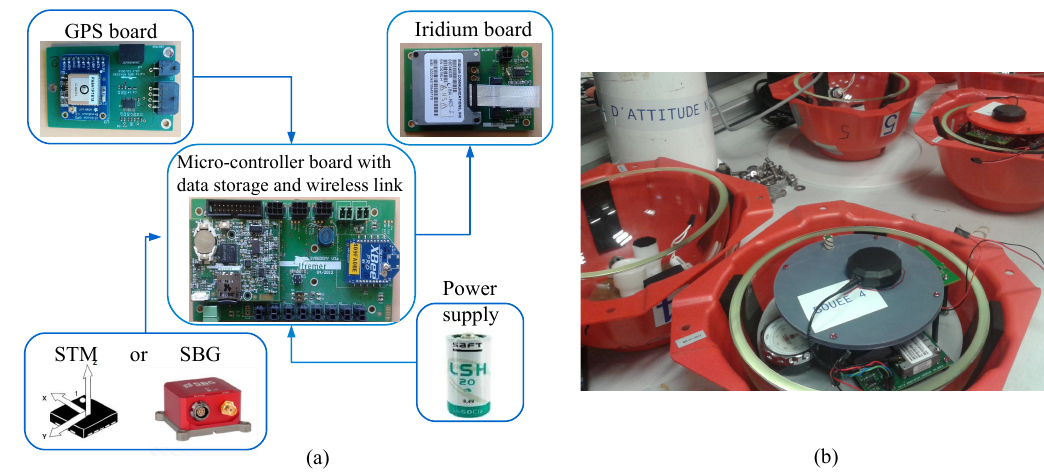
Figure 1. Surface kinematic buoy (SKIB) (a) main electronics components: microcontroller board (EFM32 cortex M3), with data storage and wireless link; GPS board; Iridium board; STM accelerometer or SBG IMU Ellipse N. (b) SKIBs with top cover removed, showing the 25.4cm diameter glass spheres used to seal all the electronic components.